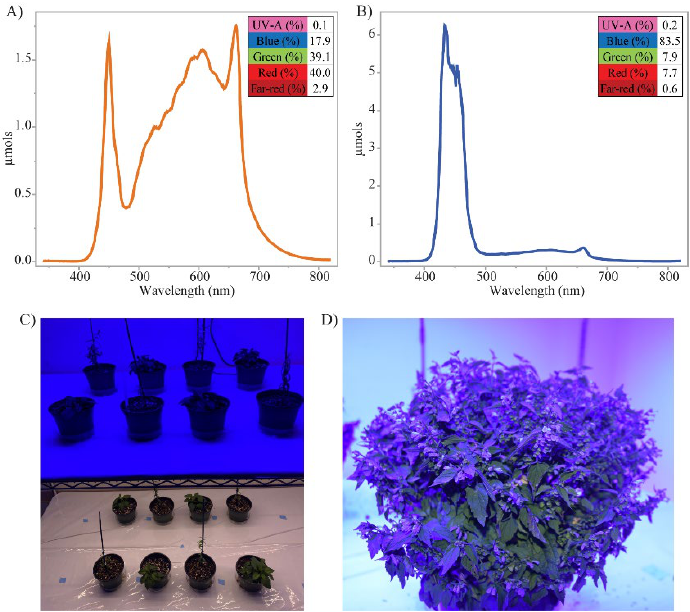
Figure 2. Spectral distribution and percentage wavelength measured at total photosynthetic photon flux density (PPFD) of 300 µ mol m − 2 s − 1 . Each lighting treatment utilized a 16 h photoperiod. ( A ) Full spectrum control ( B ) Blue light treatment is defined as blue light fraction of PPFD to be 83.5% supplemented with other wavelengths as indicated. ( C ) Light treatments implemented. Top: Blue light treatment, Bottom: Full spectrum control. ( D ) S. lateriflora plant under blue light treatment. Spectra are categorized as: UV-A (315–400 nm), blue (400–500 nm), green (500–600 nm), red (600–700 nm) and far-red (700–800 nm). Both light treatments have same PPFD and photoperiod.